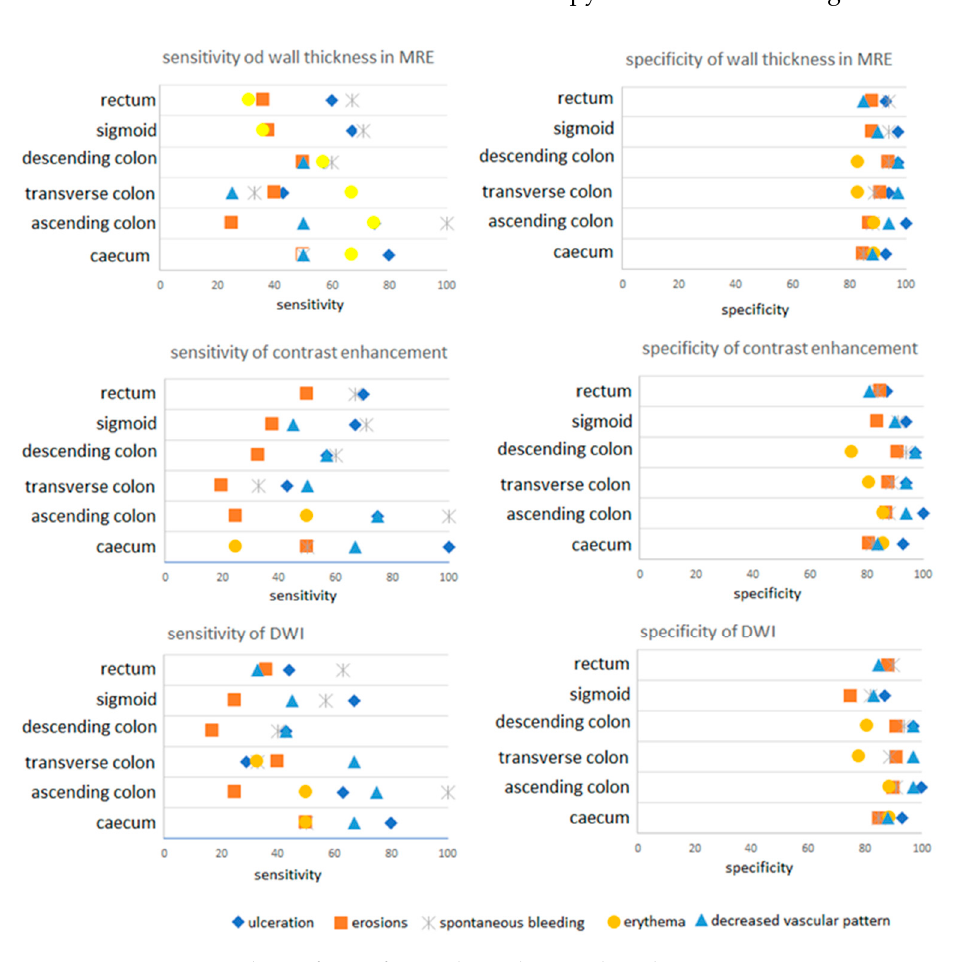
Figure 1. Sensitivity and specificity of MRE depending on the colon segment. Wall thickness was dependent on the type of lesion and colon segment. If ulceration was present, the mean thickness ranged from 4.1 mm (± 2.2; for the transverse colon) to 6.6 mm ± 1.7 for the caecum), with p < 0.05 for all segments. If ulcers were not present, thickness ranged from 3 mm for the ascending colon and sigmoid, to 3.6 mm ( ± 2.6) for the caecum. The presence of erosions did not show a statistical significance on the